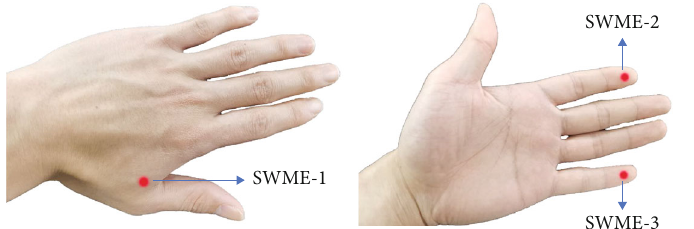
Figure 3: The assessment sites for the Semmes Weinstein mono fi lament examination.